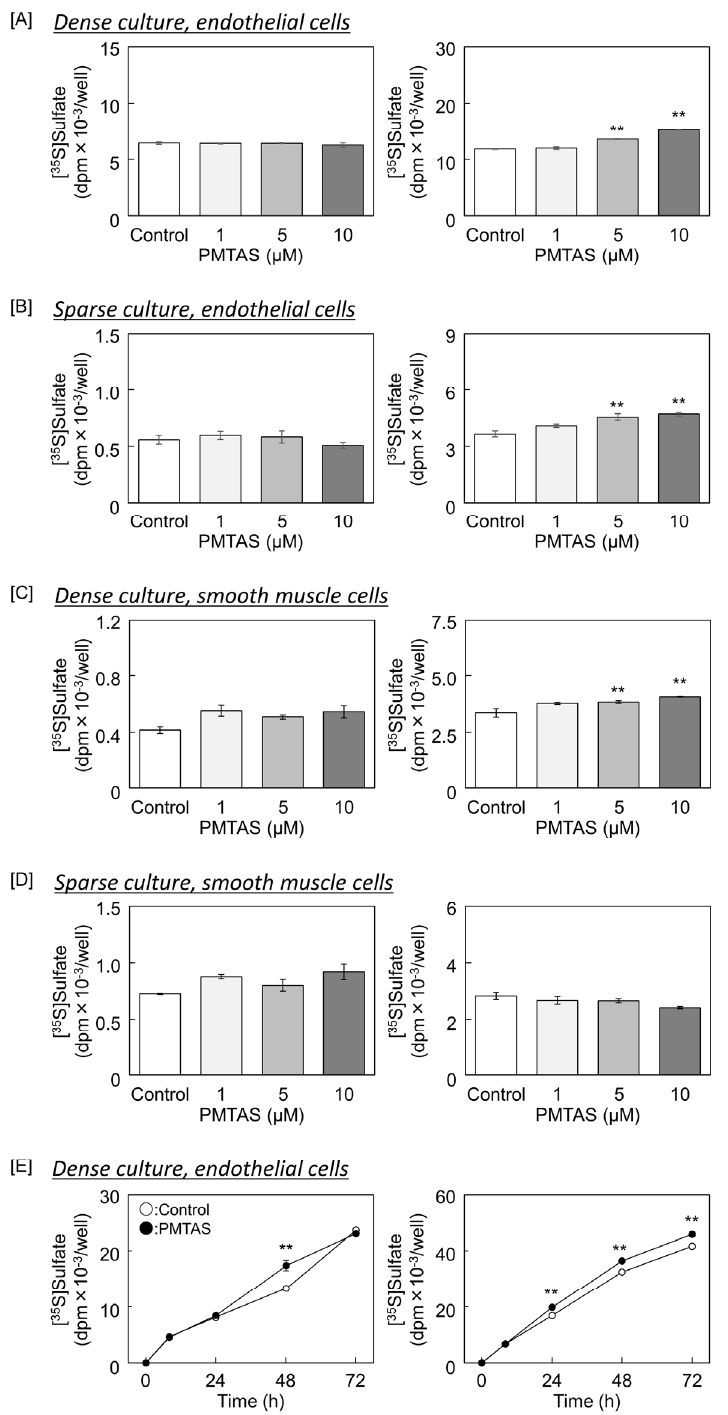
Figure 2. [ 35 S]Sulfate incorporation into the proteoglycans that accumulated in the cell layer ( left panels ) and conditioned medium ( right panels ). ( A – D ) Dense and sparse cultures of vascular endothelial and smooth muscle cells treated with PMTAS (1, 5, and 10 µ M) for 24 h; ( E ) or with PMTAS 10 µ M for 8, 24, 48, and 72 h. ( A , E ) Dense cultures of vascular endothelial cells, ( B ) sparse cultures of vascular endothelial cells, (C) dense cultures of vascular smooth muscle cells, (D) sparse culture of vascular smooth muscle cells. Values are means ± S.E. of three samples. ** p < 0.01 vs. the corre- sponding control.